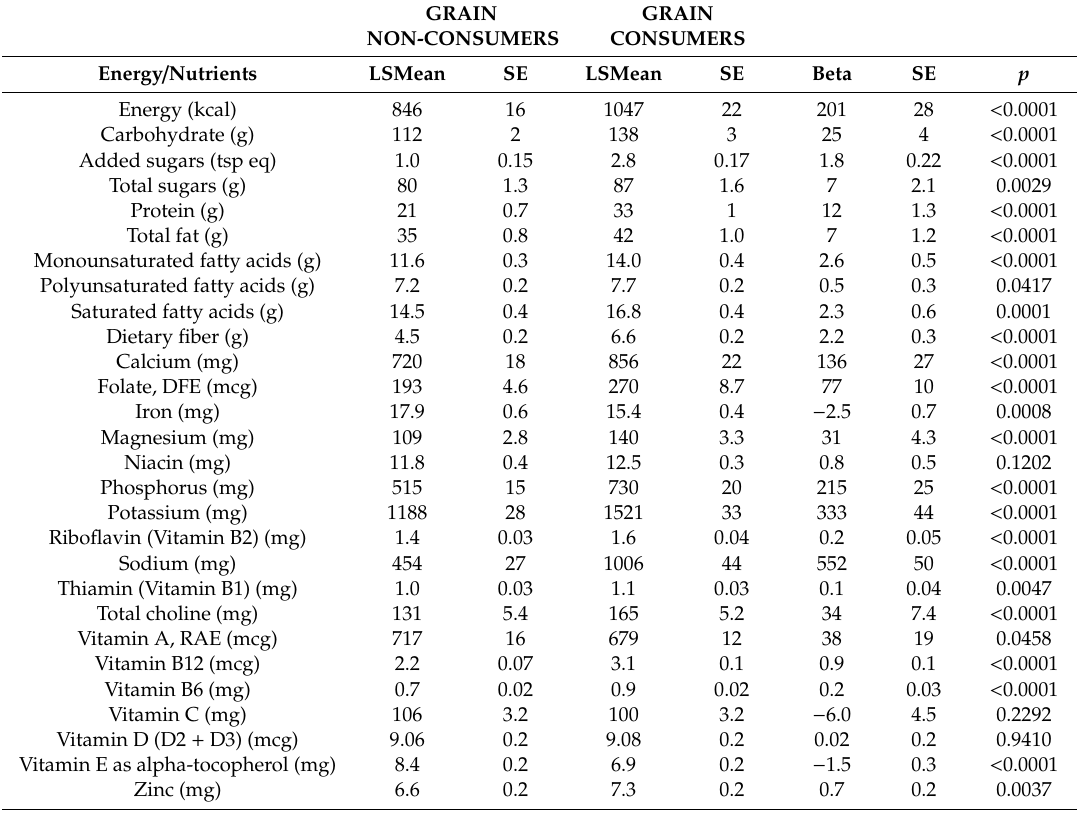
Table 1. Daily mean energy and nutrient intakes in 6- to 12-month-old grain consumers vs. grain non-consumers.